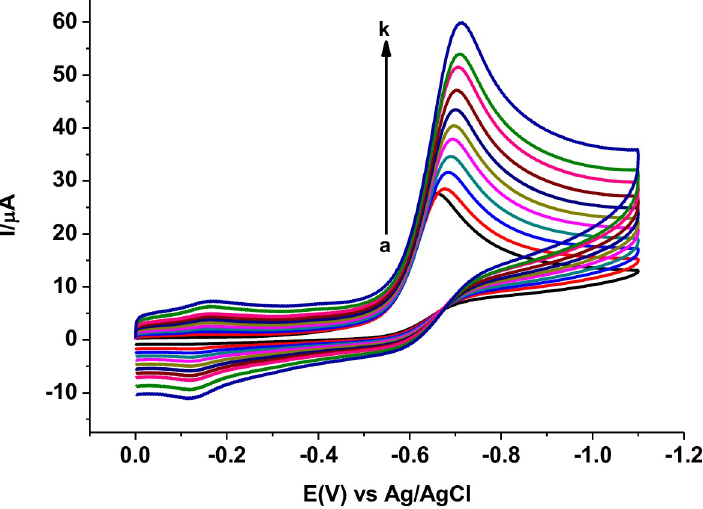
Fig 6. Cyclic voltammograms of 1.0 mM MTZ in pH 7.0 PBS at PARS/GCE at various scan rates (a–k: 20, 40, 60, 80, 100, 125, 150, 175, 200, 250, and 300 mV s -1 , resp.).